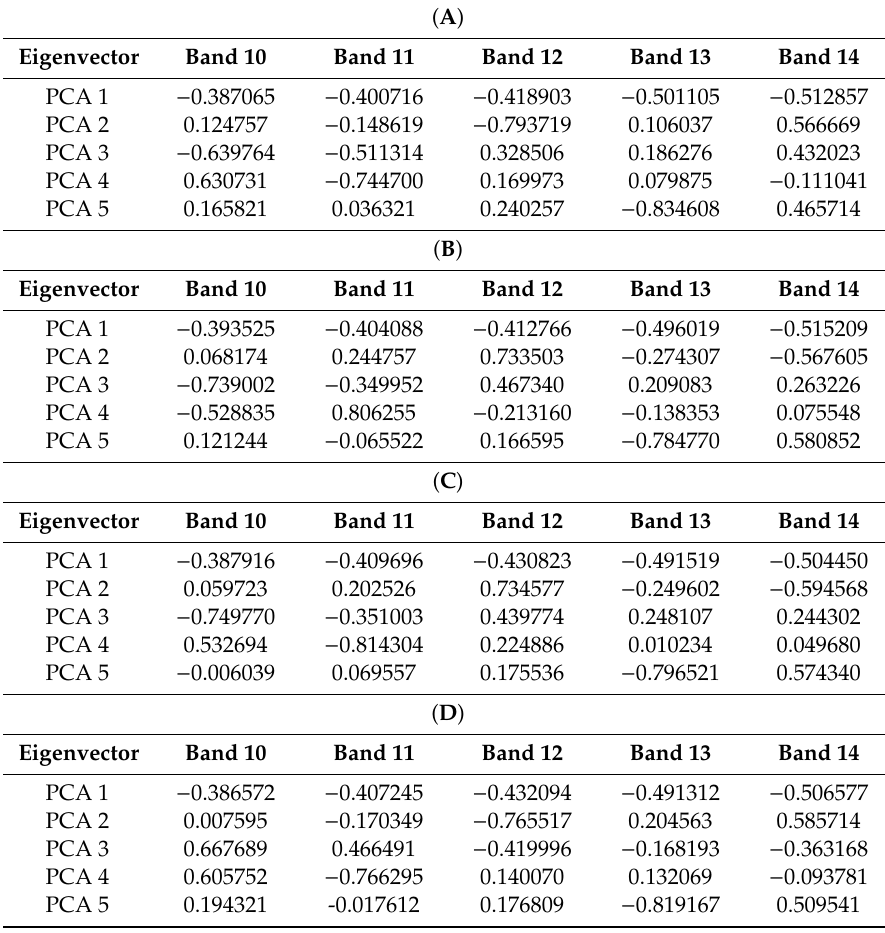
Table A2. Eigenvector matrix for TIR bands of ASTER. ( A ): Spatial subset covering zone 1 and surrounding areas; ( B ): Spatial subset covering zones 2 and 3; ( C ): Spatial subset covering zone 4 and surrounding areas; and ( D ): Spatial subset covering zones 5 and